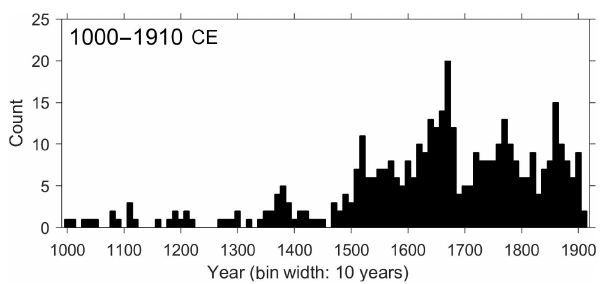
Figure 4. The numbers of typhoons occurring per decade for the period